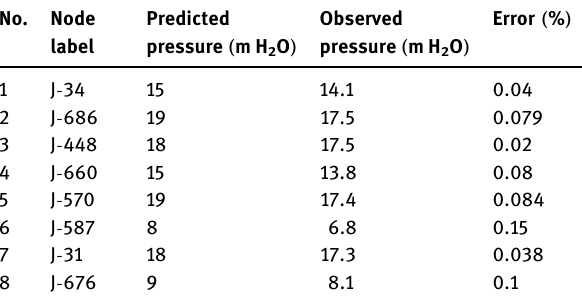
Table 2: The comparison between the analytical data and the fi eld data No. Node label